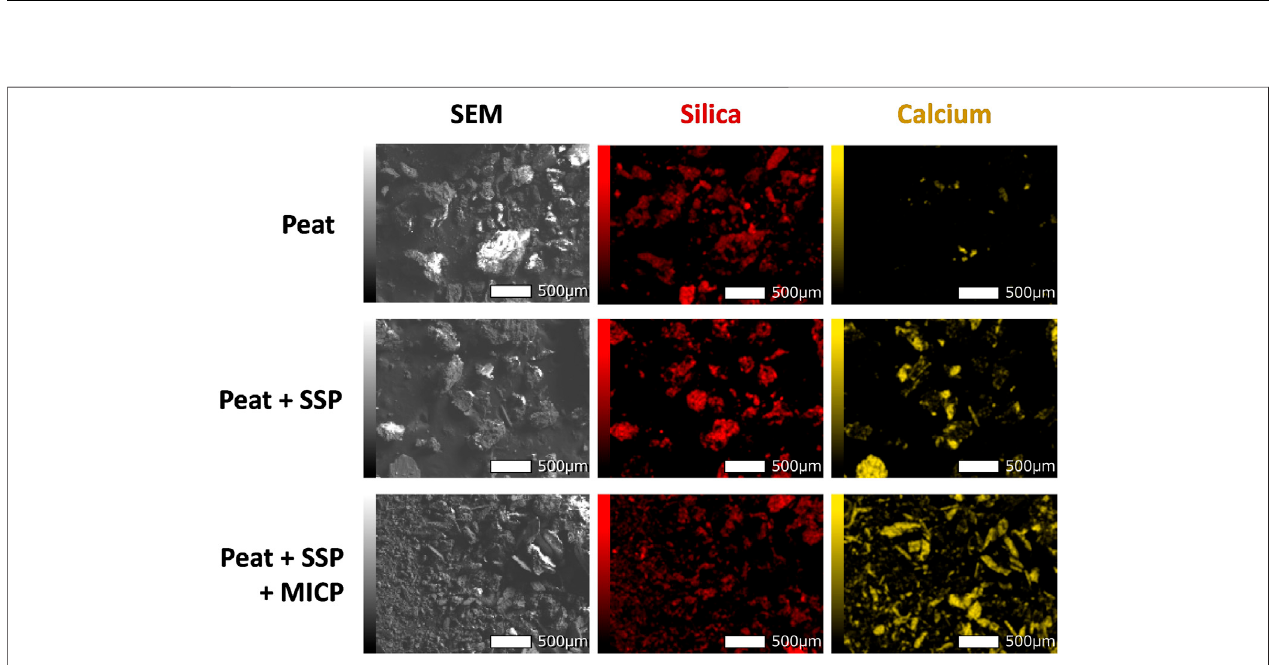
FIGURE11| SEMimagesoftheuntreatedandtreatedpeat,andtheEDXanalysisshowingdistributionofsilicaandcalciuminpeat(theareahighlightedbyredand yellow, respectively).